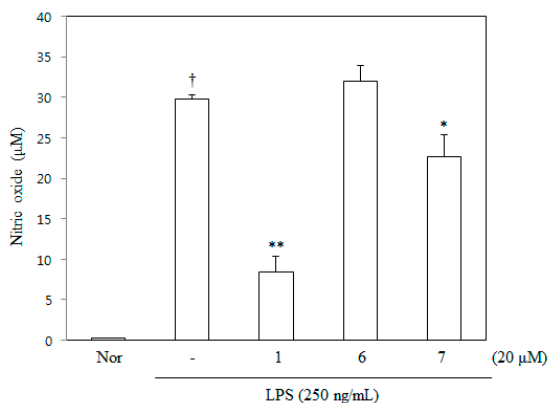
Figure 3. Effects of three non-toxic flavanones on the inhibition of LPS-stimulated NO production in RAW 264.7 cells. Cells cultured in phenol red- and serum-free media were pretreated with each compound for 1 h and then stimulated with 250 ng/mL final concentration LPS for 24 h. In the culture medium, NO production was measured based on the Griess reaction, as described in the Materials and Methods section. Nor (untreated control cells); 6,8-diprenyl-7,4 ′ -dihydroxyflavanone ( 1 ); flemichin ( 6 ); tonkinochromane A ( 7 ). Values are expressed as the mean ± SEM. † Significant difference from normal cells, * significant difference from LPS cells, p < 0.05 and ** significant difference from LPS cells, p < 0.01.